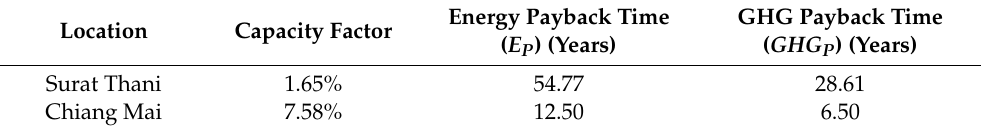
Table 8. Energy and GHG payback time for Surat Thani ( C F = 1.65%) and Chiang Mai ( C F = 7.58%).